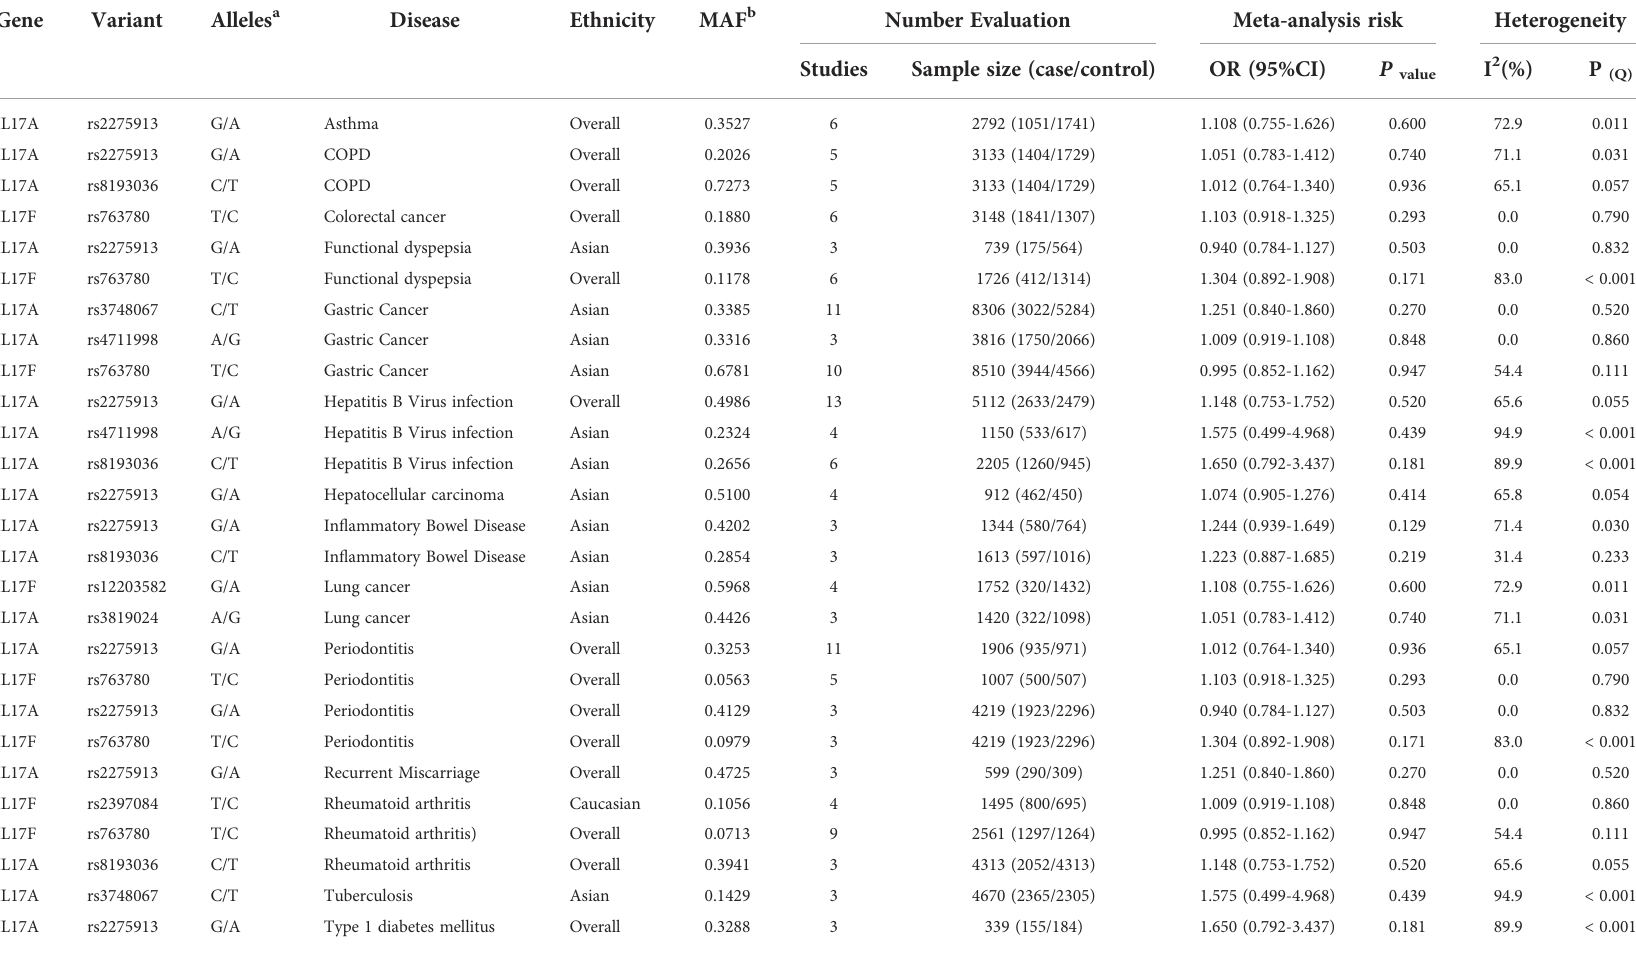
TABLE 2 Variants in IL-17 family genes showing no relation to risk of disease in meta-analyses in additive